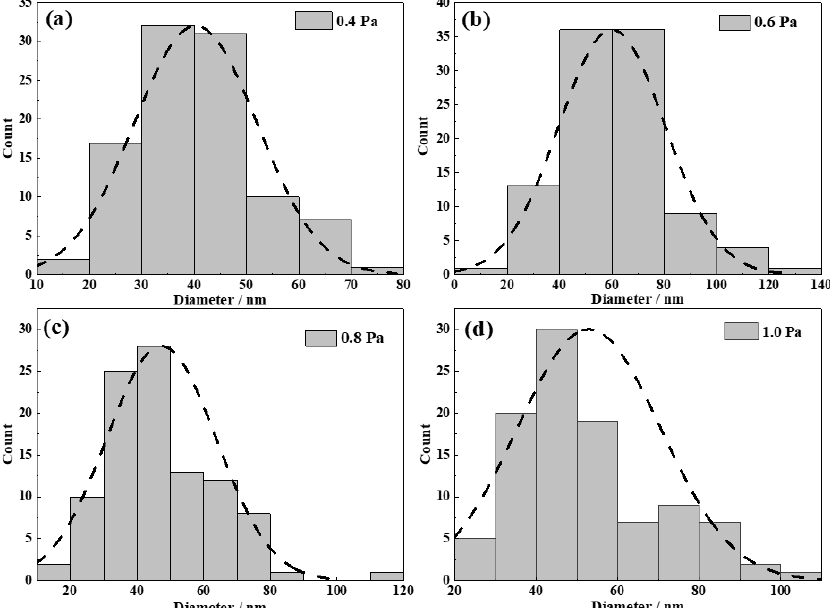
Figure 3. ( a – d ) Profile of grain size distribution of films prepared at different sputtering pressures: ( a ) 0.4 Pa, ( b ) 0.6 Pa, ( c ) 0.8 Pa and ( d ) 1.0 Pa.